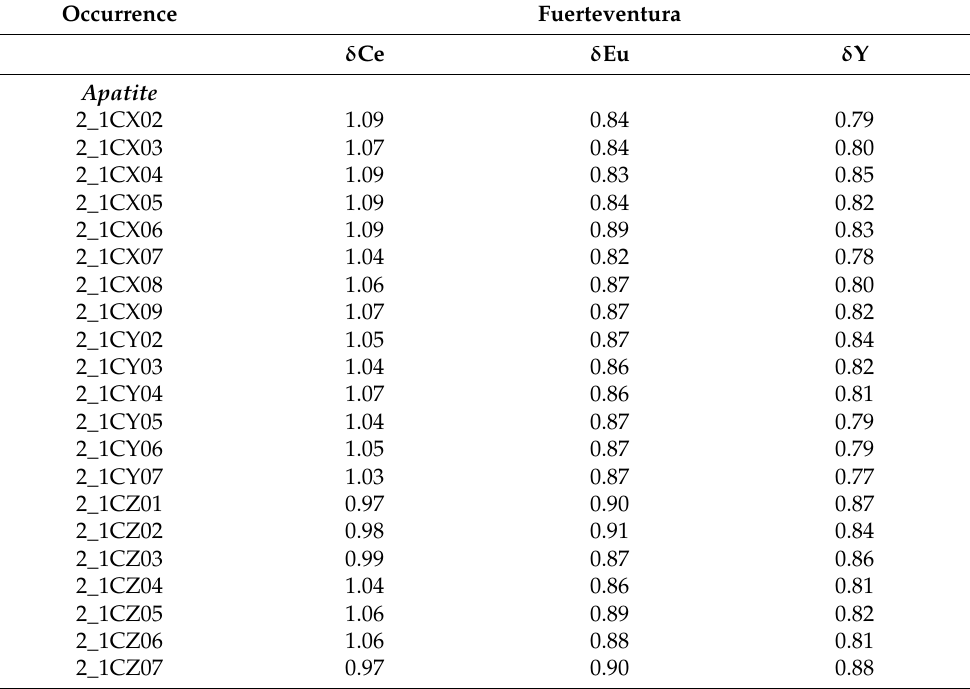
Table A3. δ Eu, δ Y, and δ Ce of apatites from Fuerteventura carbonatites plotted in Figure 5.